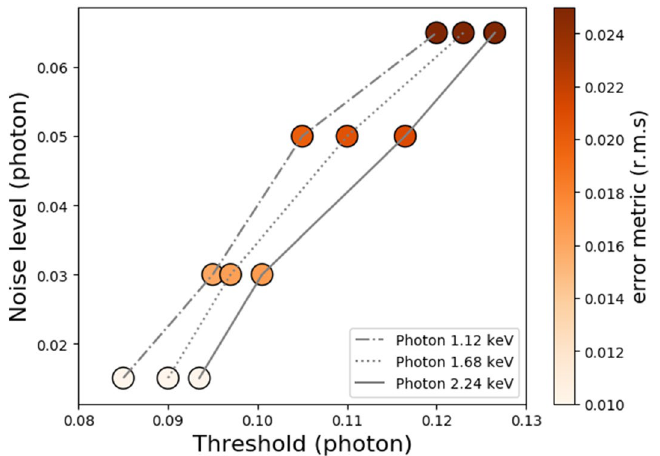
Figure 7. Absolute contrast extraction for different energies (1.12, 1.68, 2.24 keV) and level of noise readout. Only the optimal threshold is reported for the different conditions since its counterpart σ G is common to all the results with a value of 0.4. The minimum value of the error metric is color coded for each of the absolute contrast